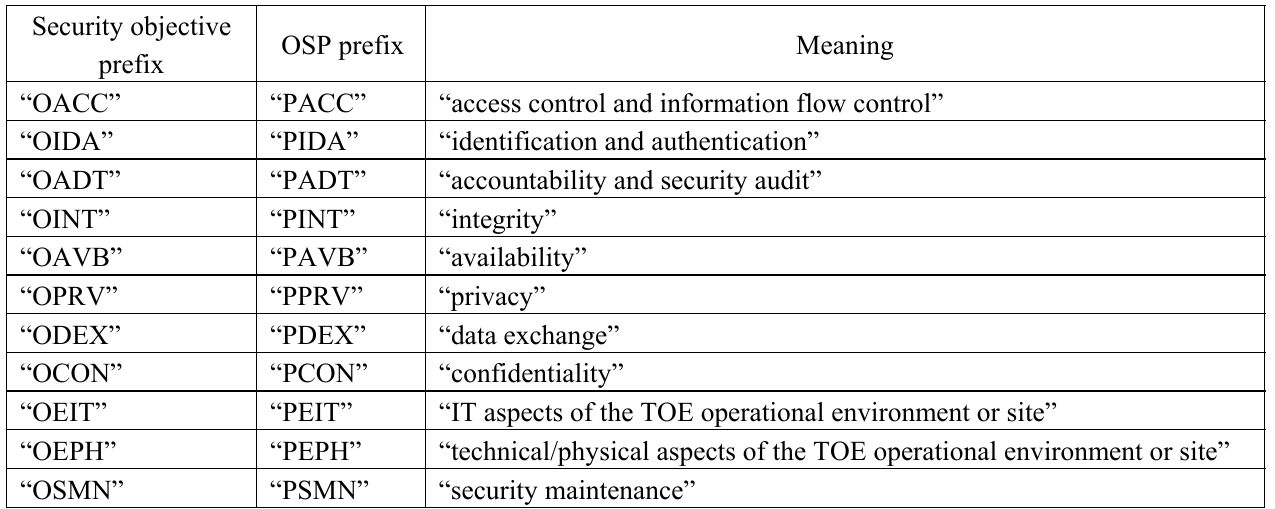
Table 6. Family field for Organizational Security Policies and security